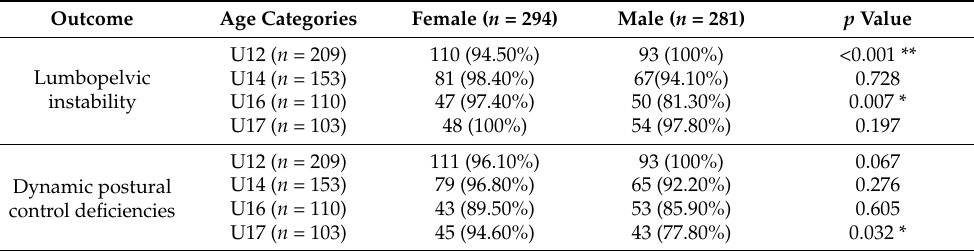
Table 5. Lumbopelvic and postural instability for between-group comparisons of U12 to U17 basket- ball players.